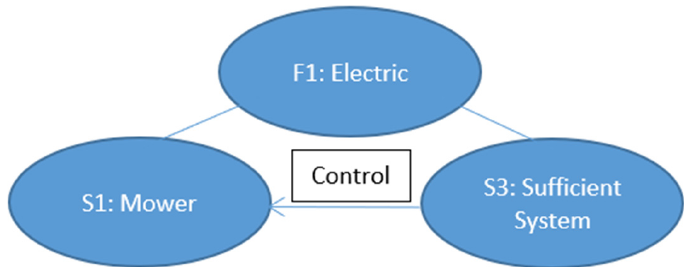
Figure 10. Improved Su-field model for constraint 3.